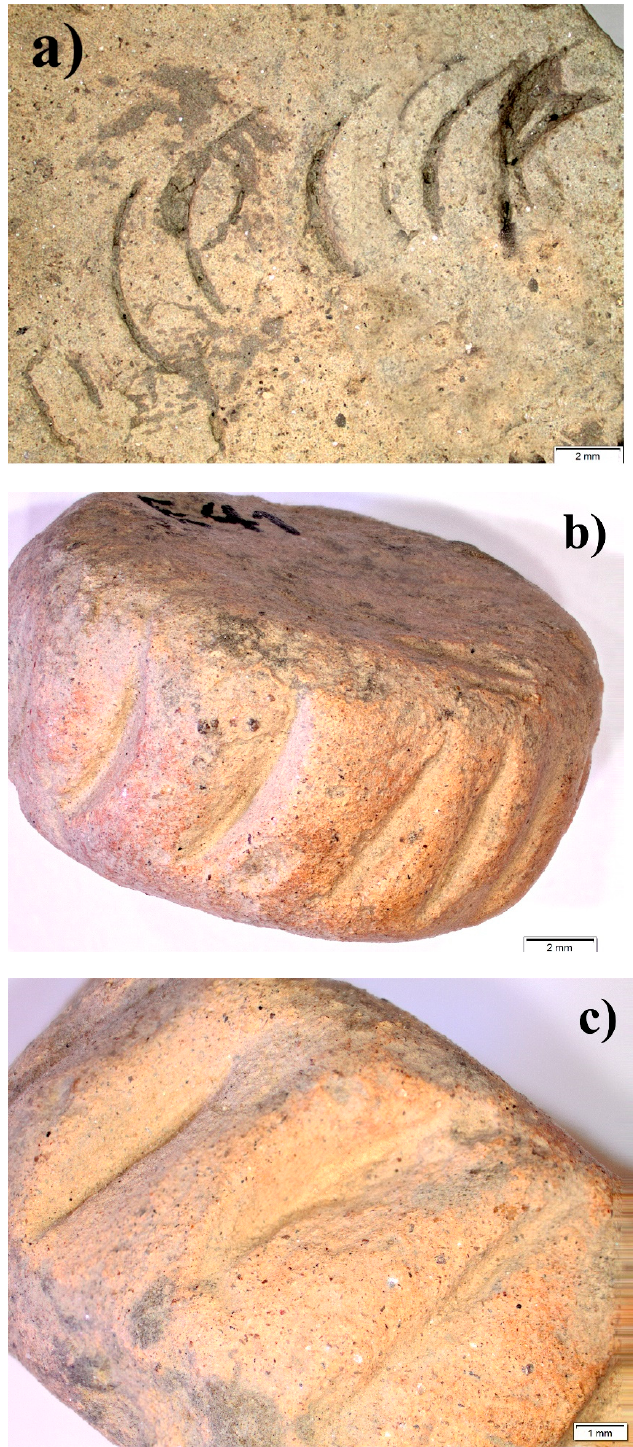
Figure 3. ( a ) nail marks visible on the flat surface of the VF-pU210-E10 washer disc; ( b , c ) vertical nail incisions made on the lateral edge of the VF-pd571-E41 washer disc. The scale bars are ( a , b ) 2 mm, and ( c ) 1 mm.